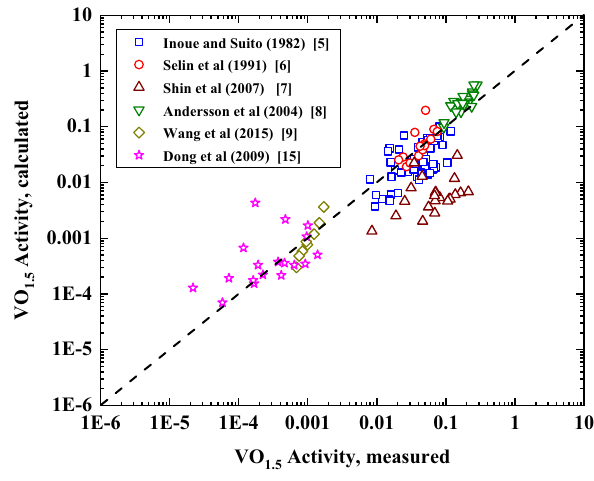
Figure 2: Comparison of the calculated VO 1.5 activities in various slags by GCA model with the experimental measurements [ 5 – 9,15 ]